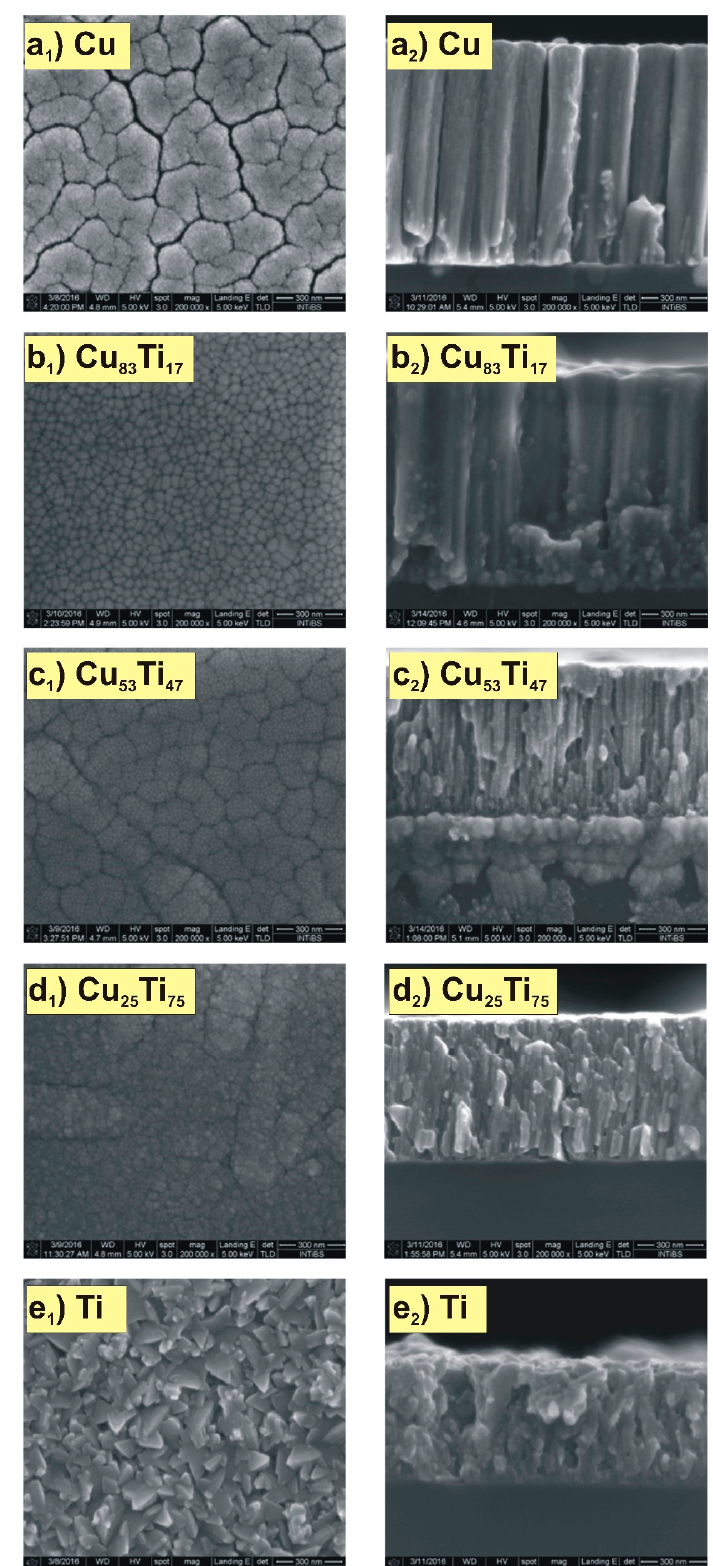
Figure 2. SEM images of prepared coatings: ( a ) Cu, ( b ) Cu 83 Ti 17 , ( c ) Cu 53 Ti 47 , ( d ) Cu 25 Ti 75 , and ( e ) Ti, as-deposited on Si substrates. Designations: (1) surface, and (2)